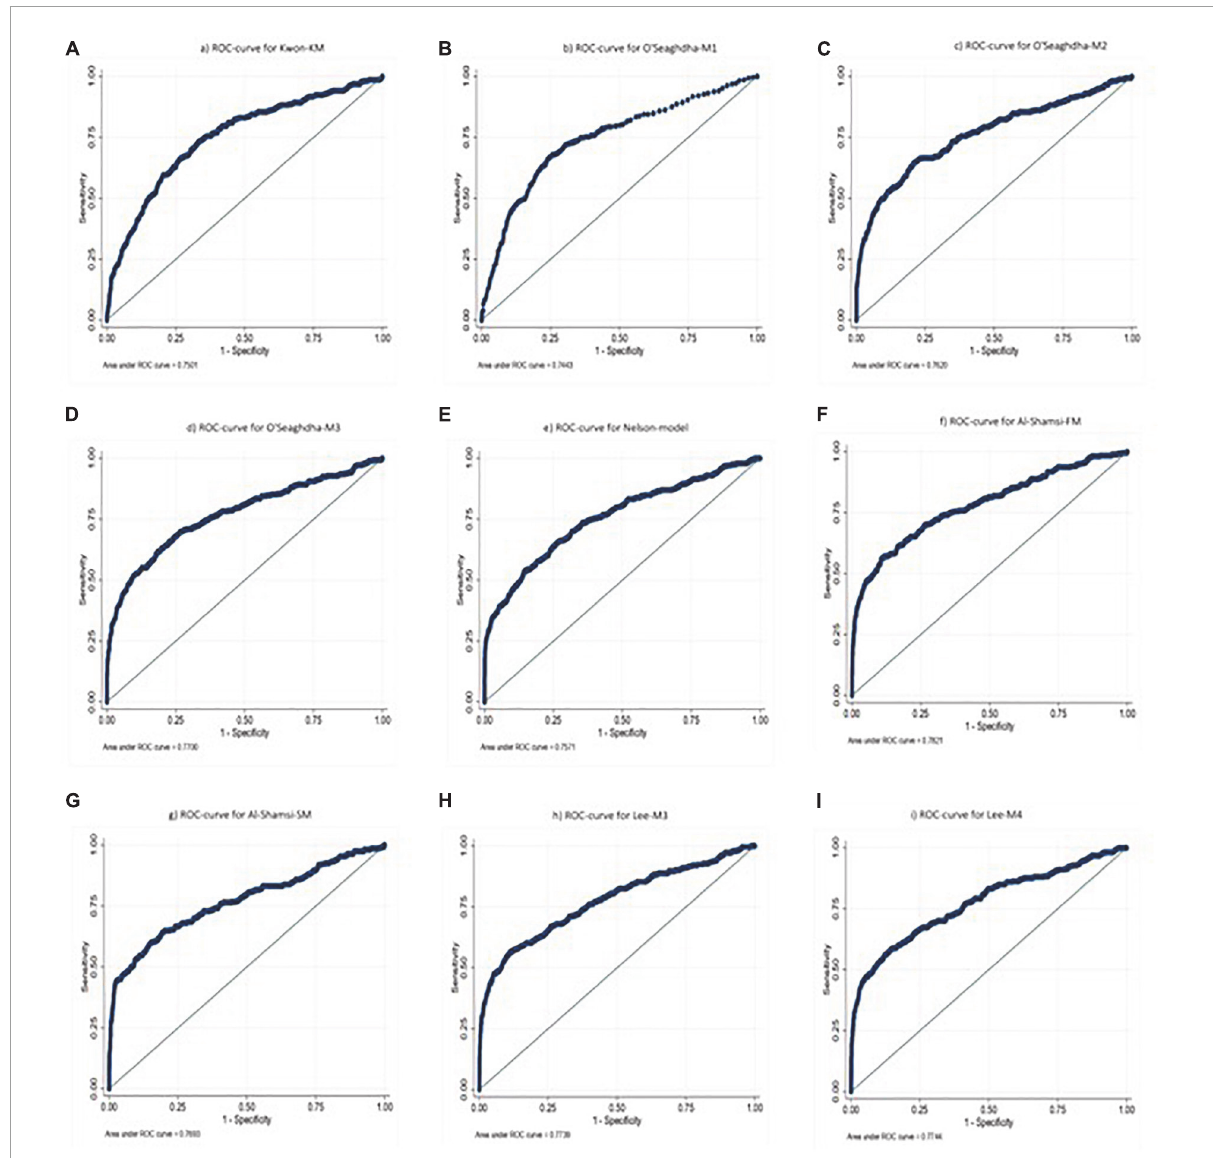
FIGURE2 Area under the curve of risk predictive models of chronic kidney disease previously described in the Mexican population, using data of the National Health and Nutrition Survey 2016: (A) Kwon Korean model, (B) O’Seaghdha model 1, (C) O’Seaghdha model 2, (D) O’Seaghdha model 3, (E) Nelson model, (F) Al-Shamsi full model, (G) Al-Shamsi stepwise model, (H) Lee model 3, and (I) Lee model